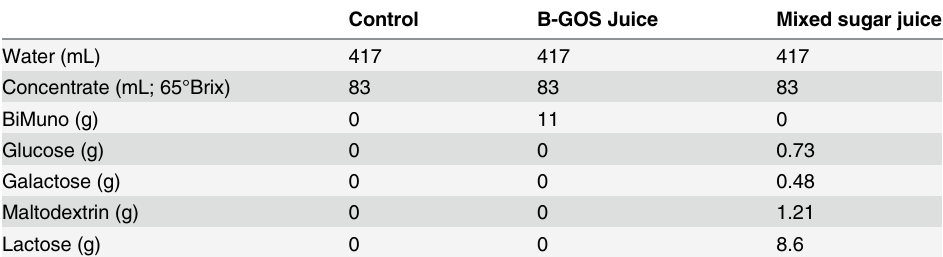
Table 2. Ingredients for orange juice